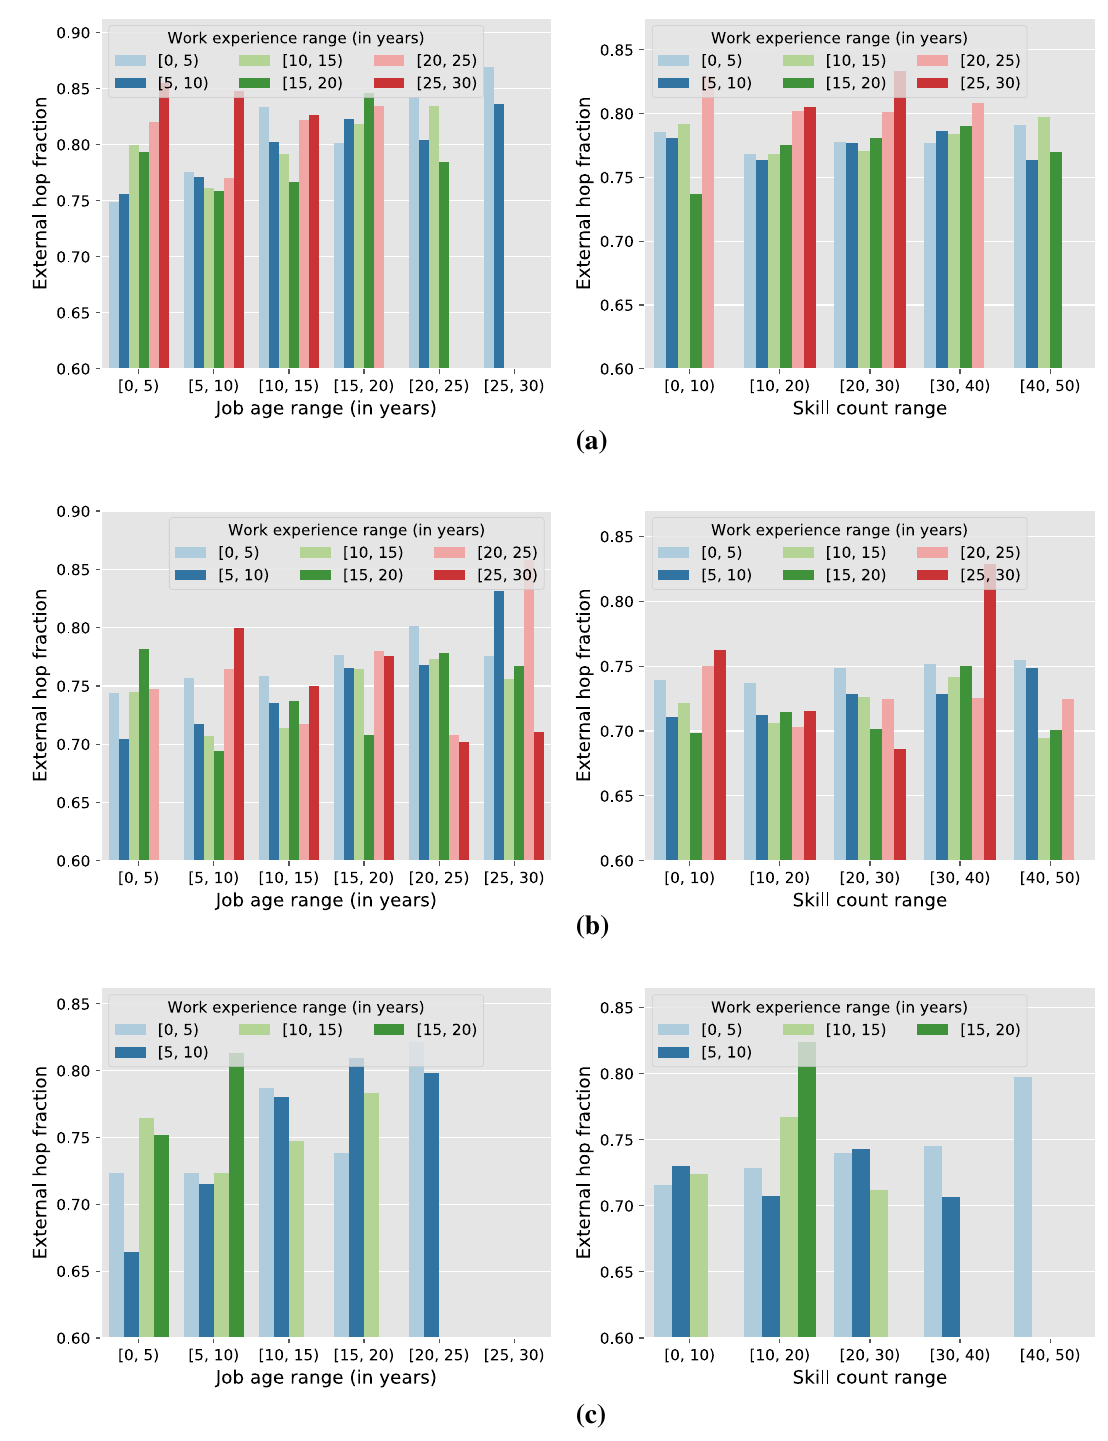
Fig. 10 Distributions of external hop fraction. a Singapore. b Switzerland. c Hong